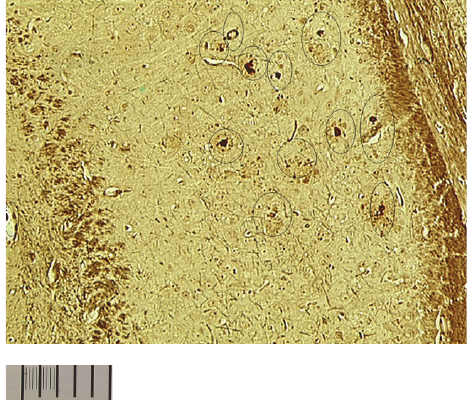
Figure 7: Hippocampal pathology in 3 × Tg Bielschowsky Stain